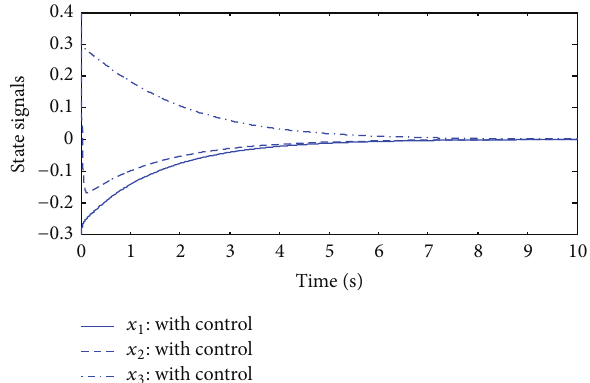
Figure1:Transientresponseofstatesignals:closedloopsystemwith = [−0.3 0.4 0.3] 𝑇 . 𝑥 0